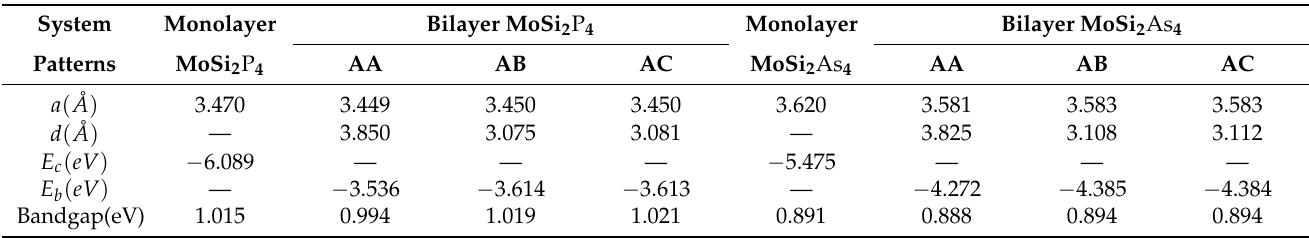
Table 1. Lattice constants a , interlayer distance d , cohesive energy E c , binding energy E b and band gap of few-layer MoSi 2 Z 4 (Z = P,